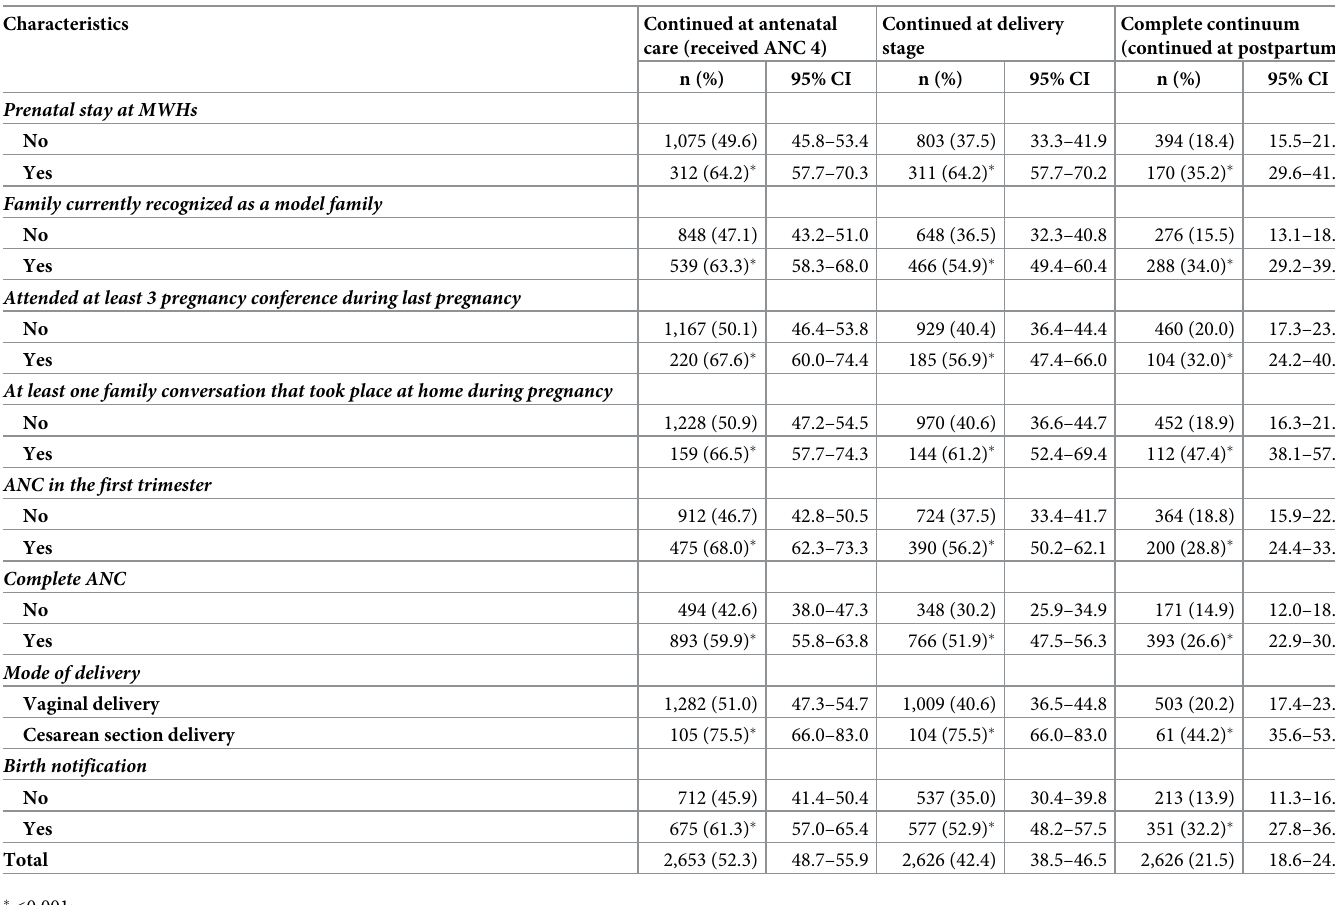
Table 4. Distribution of maternal health services across the CoC in Ethiopia, by health-service related and obstetric characteristics, 2017.